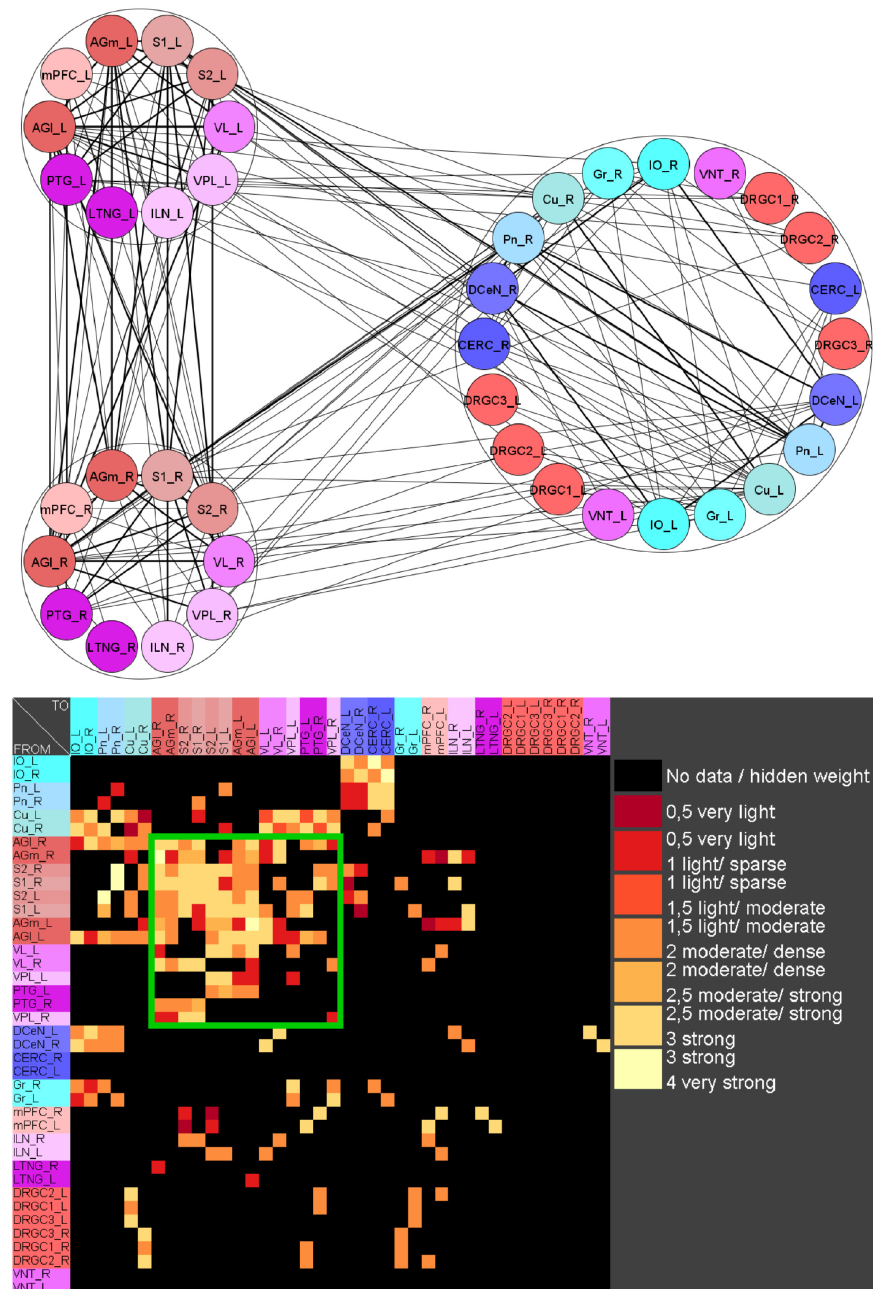
Fig 10. Modularity and spectral cluster analysis. The modularity analysis of connectivity similarity among regions generates 3 modules. The spectral cluster analysis of the connectivity matching matrix reveal a cluster with similar regions like those of the clustered cross-correlation